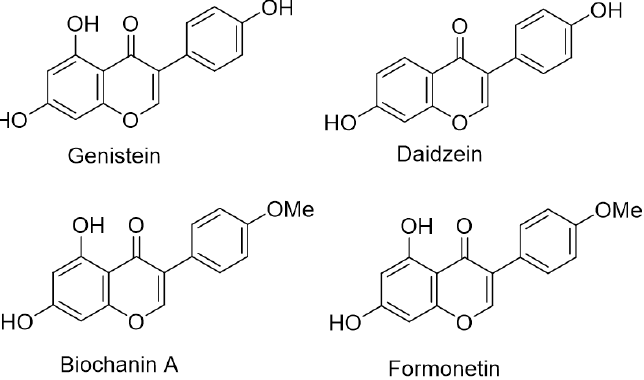
Figure 1. Examples of bioactive isoflavones.